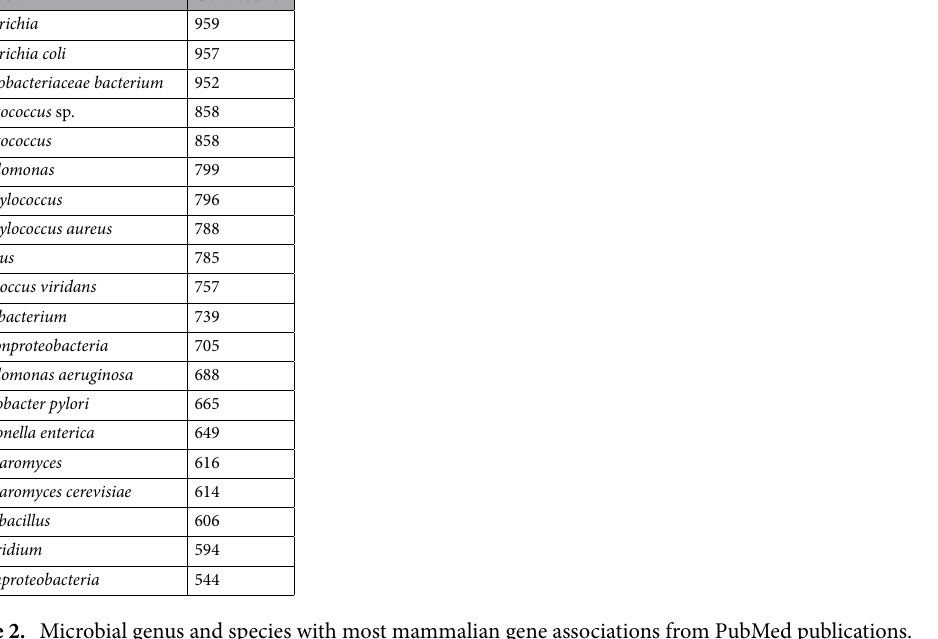
Table 2. Microbial genus and species with most mammalian gene associations from PubMed publications.